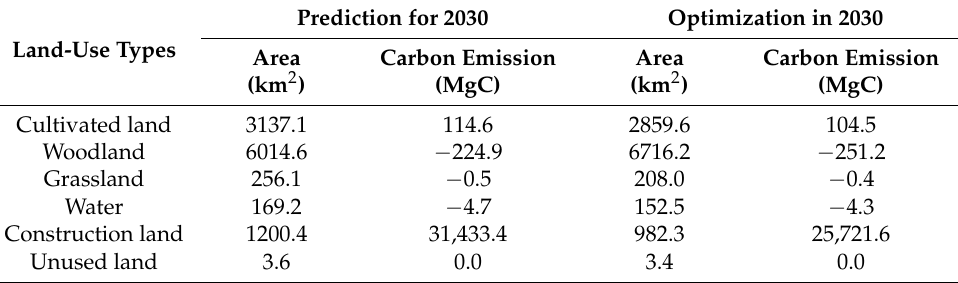
Table 9. Carbon emissions in 2030 for the predicted and optimized land-use